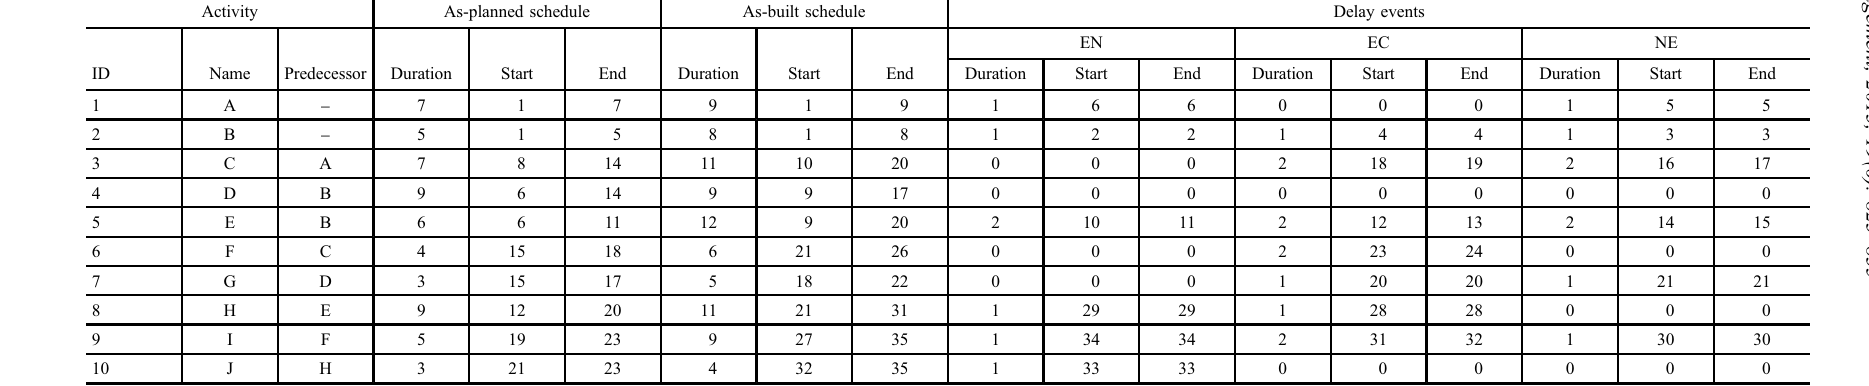
Table 4. Details of the tested delay